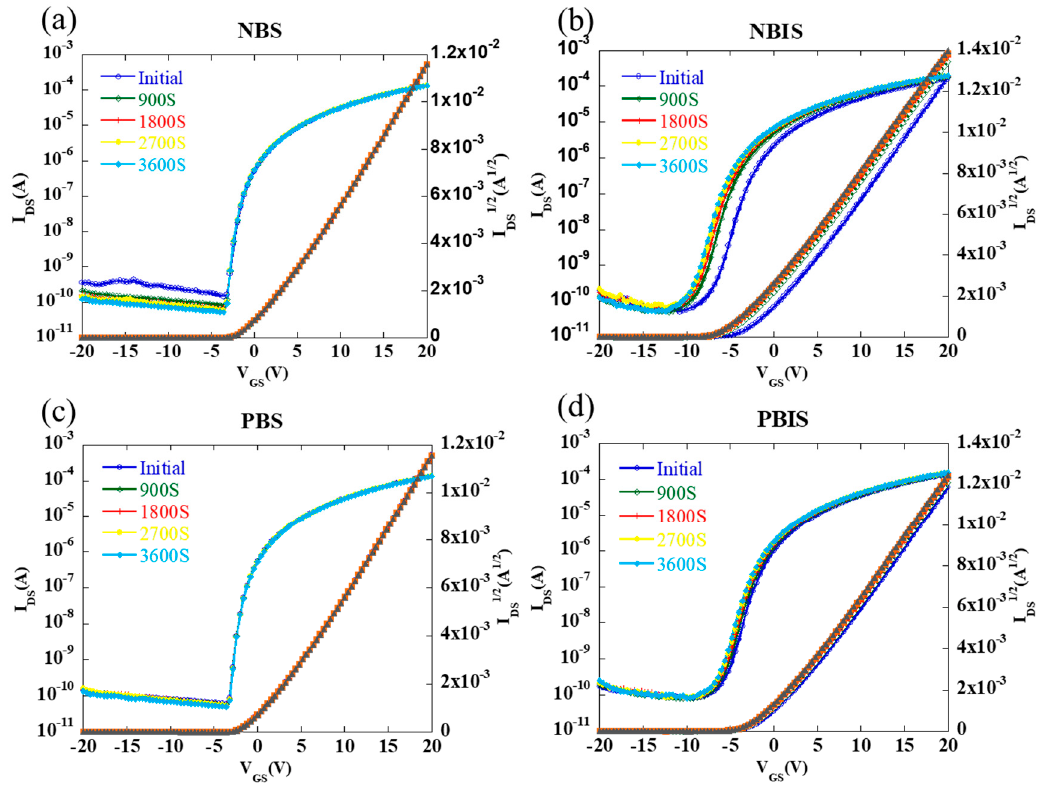
Figure 5. Variations of the transfer curves under ( a ) negative bias stress, ( b ) negative bias stress under illumination, ( c ) positive bias stress, ( d ) positive bias stress under illumination. During the test, a positive gate bias (V G = 10 V, V DS = 10 V) and a negative gate bias (V G = − 10 V, V DS = 10 V) was applied as an electrical stress for 1 h, respectively. Transfer curves were recorded every 15 min. Table 2. Summary of the V th of the coplanar top ‐ gate TFTs under various bias stress.